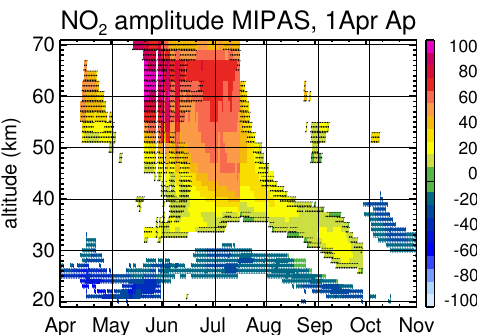
Figure 6. Same as Fig. 3, but only for the NO 2 amplitude associated to 1 April Ap index. The NO 2 was derived from MIPAS observa- tions from 2005 to